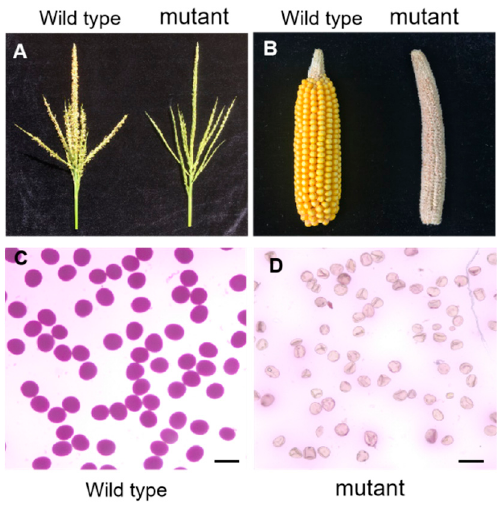
Figure 1. Phenotypic characterization of the wild type and mutant. ( A ) Comparison of a wild type tassel (left) and a mutant tassel (right); ( B ) Comparison of a wild type ear and a mutant ear after being pollinated with wild type male pollen grains; ( C ) Alexander-staining of normal pollen grains in the wild type; ( D ) Alexander-staining of sterile pollen grains in the mutant. Scale bar = 100 µm.